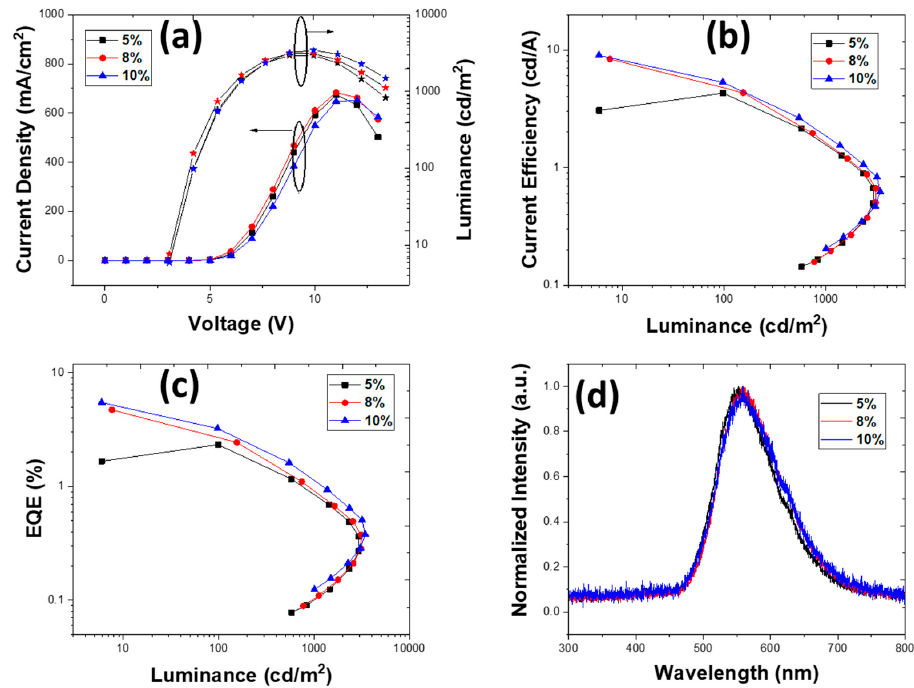
Figure 5. Device characteristics for structure ITO/PEDOT:PSS (40 nm)/PVK:OXD-7:TXO-TPA (x wt.%) (25 nm)/TmPyPb (40 nm)/LiF (1 nm)/Al (100 nm) deposited from dichlorobenzene. ( a ) Current density vs. voltage vs. luminance, ( b ) current efficiency vs. luminance, ( c ) EQE vs. luminance, and ( d ) electroluminescence spectra for 5, 8, and 10 wt.% (at 14 V).